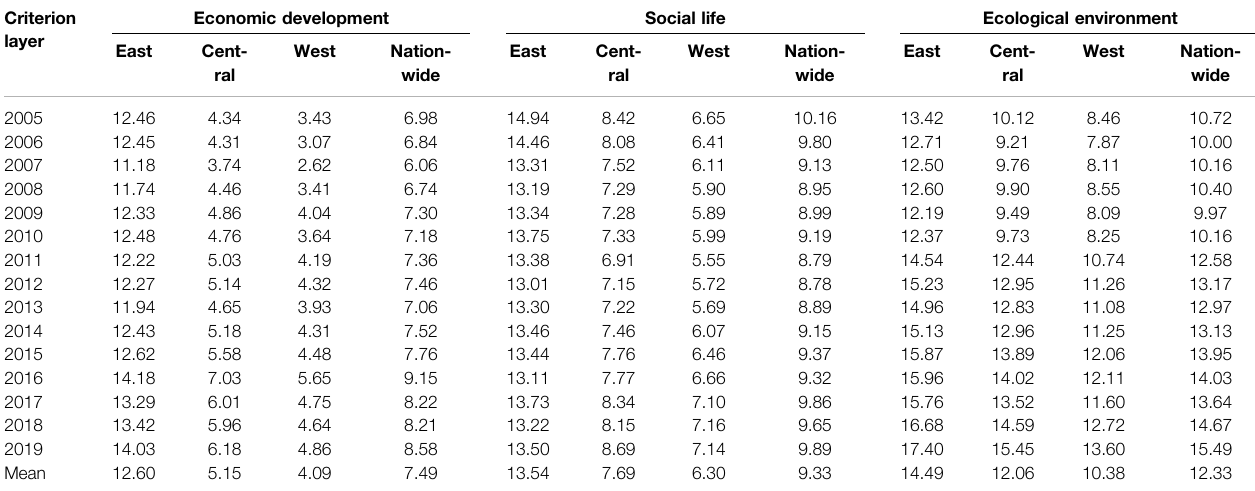
TABLE 3 | The scores of three criterion layers.